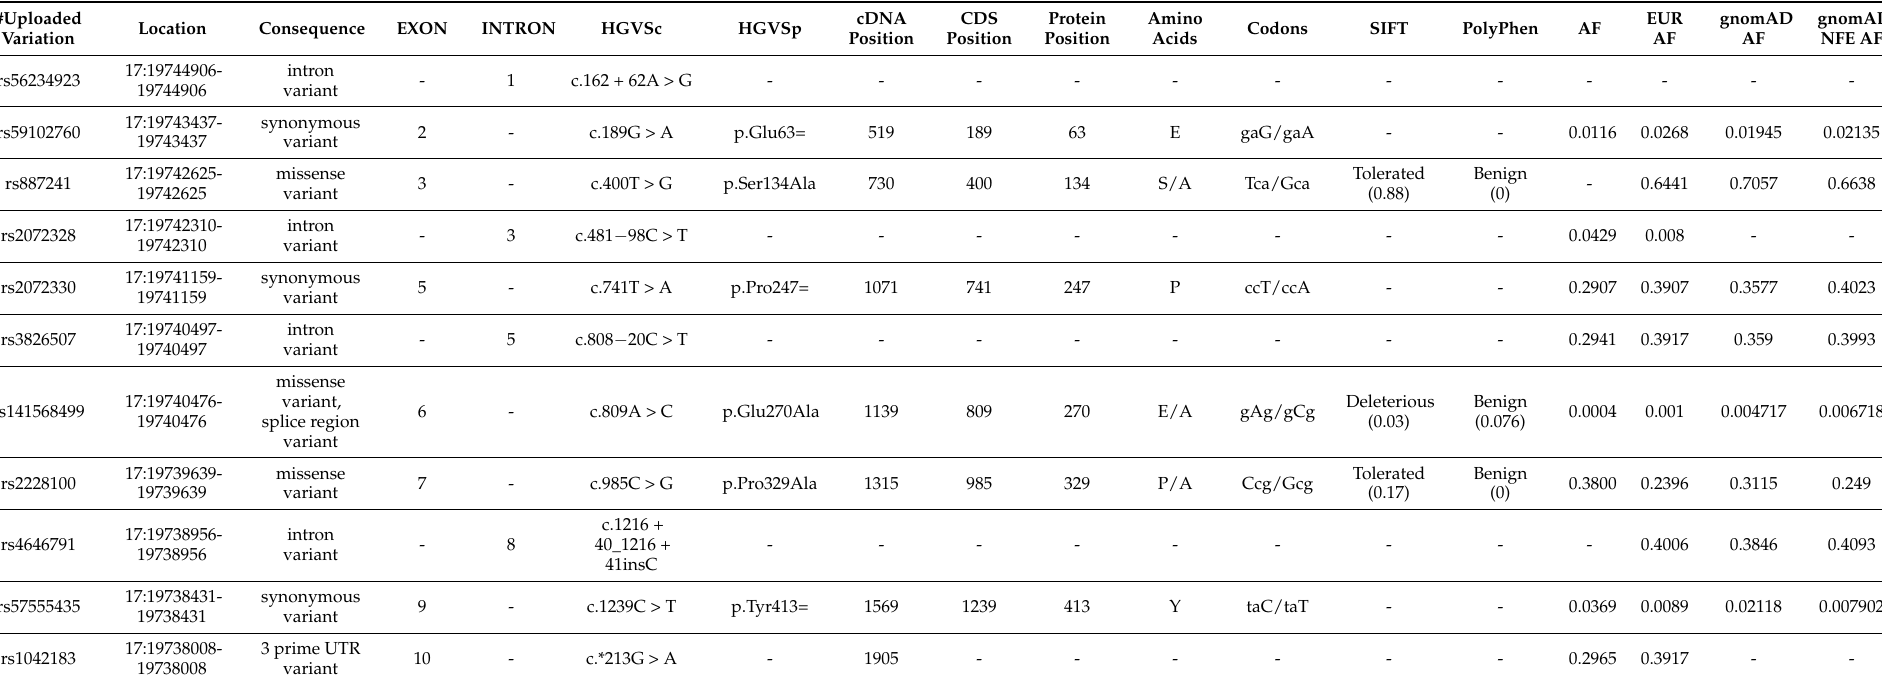
Table A1. ALDH3A1 variants identified in the pilot group of KC patients ( n = 28) (data from: Variant Effect Predictor, ensemble.org; Variant Effect Predictor— Homo_sapiens—Ensembl genome browser